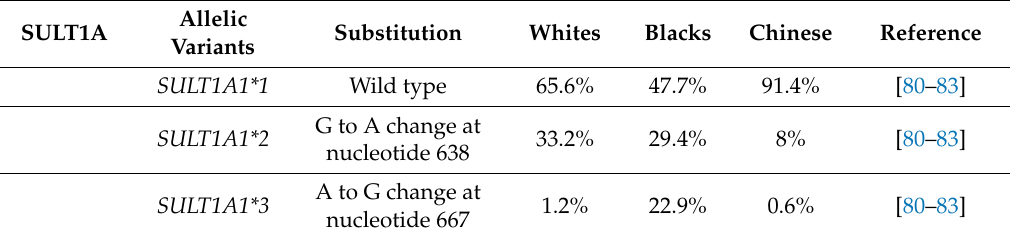
Table 3. Allelic variants of sulfomethyl transferase SULF1A1 that affect the pharmacokinetic metabolism of